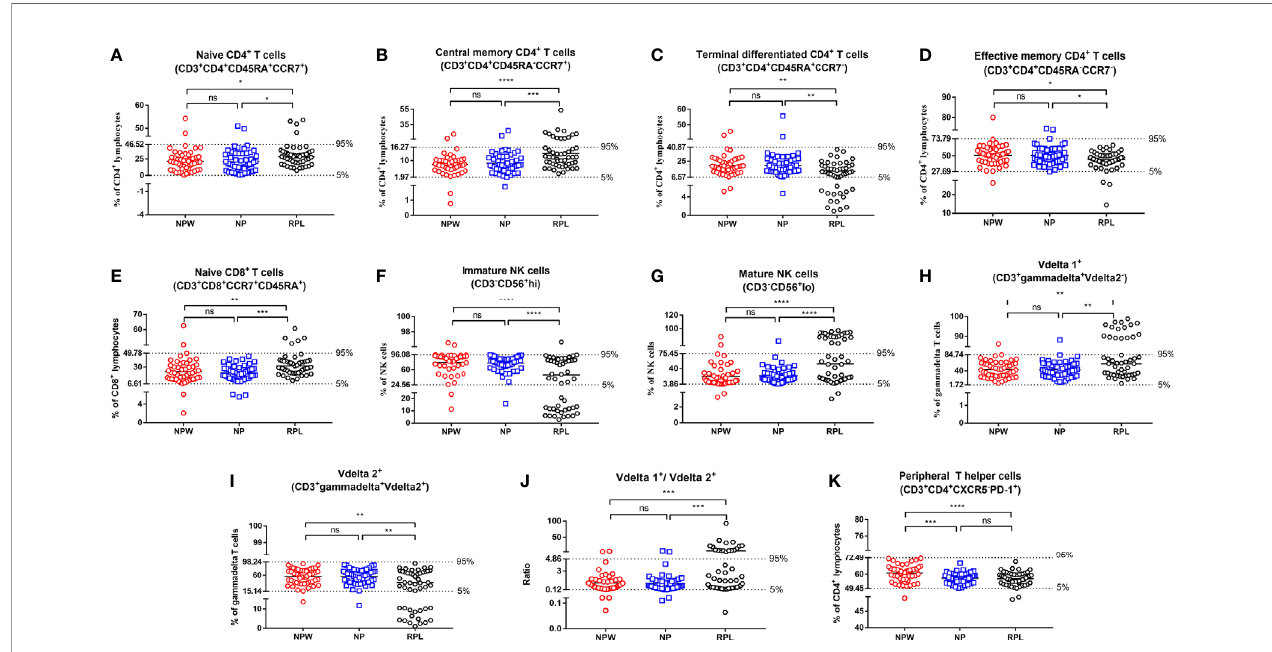
FIGURE 3 | Reference ranges for the signi fi cantly changed immune parameters. (A – J) Reference ranges for signi fi cantly changed immune parameters related to RPL. The percentages of naïve CD4 + T cells (A) , central memory CD4 + T cells (B) , naïve CD8 + T cells (E) , mature NK cells (G) , V d 1 + T cells (H) and the ratio of V d 1 + T cells/V d 2 + T cells (J) were signi fi cantly higher in the RPL group than those in the NPW and NP groups. The percentages of terminal differentiated CD4 + T cells (D) , effective memory CD4 + T cells (D) , immature NK cells (F) and V d 2 + T cells (I) were signi fi cantly lower in the RPL group than those in the NPW and NP groups. The mean + 1.96 SD was used to measure the reference ranges for the normally distributed data. Median and 5th/95th percentiles represented the lower/upper limit to set up the reference ranges for skewed distribution data. In 14%- 40% of women with RPL, the percentages of central memory CD4 + T cells (B) , mature NK cells (G) , the ratio of V d 1 + T cells/V d 2 + T cells (J) , and V d 1 + T cells (H) were above the 95th percentile limit. In 28% - 40% of women with RPL group, the percentages of terminally differentiated CD4 + T cells (C) , immature NK cells (F) and V d 2 + T cells (I) were below the 5th percentile limit. The percentages of these different immunological parameters in the NP group were similar to those in the NPW group, and most were within the 5th percentile limit and 95th percentile limit. (K) Reference ranges for signi fi cantly changed immune parameters related to pregnancies. The percentage of TPH was signi fi cantly low in the NP and RPL groups compared with the NPW group. Vdelta1: Vd1; Vdelta2: Vd2. Signi fi cance levels were set to *P < 0.05, **P < 0.01, ***P < 0.001, and ****P < 0.0001, and ns means not signi fi